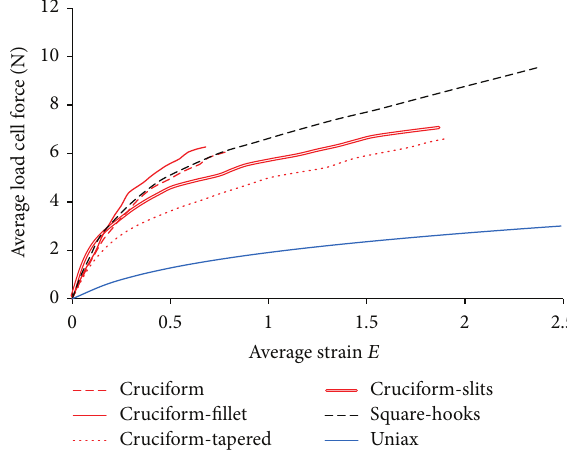
Figure 5: Average load cell force versus average Green-Lagrange strain in central